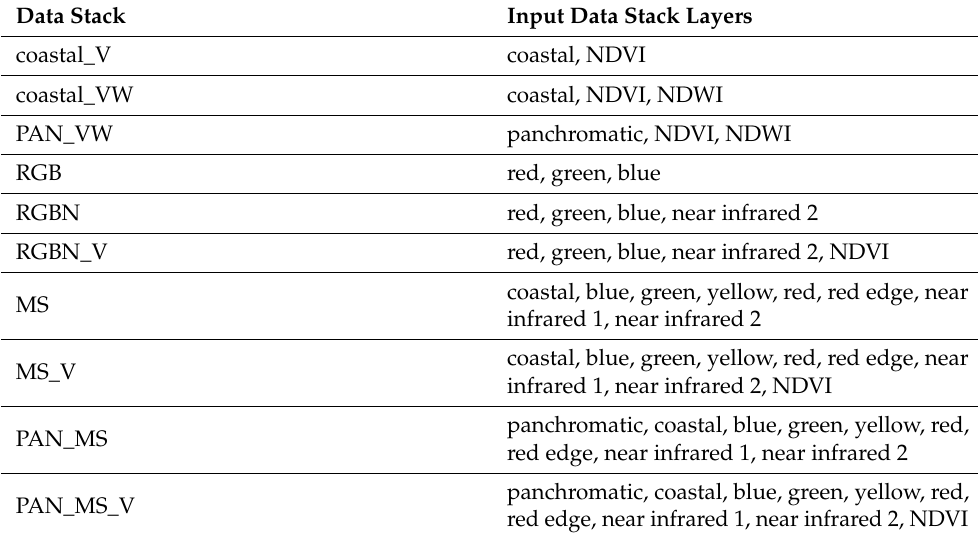
Figure 2. ( a ) Preprocessing workflow from Level-1B products to model input data stacks; ( b ) list of input data layers used to train random forest models and commonly available data stacks for spectral bands collected by earth-observing sensors. Table 2 contains all input data layer combinations used to train models presented in this work. Table 2. Input data stack layer combinations for all models